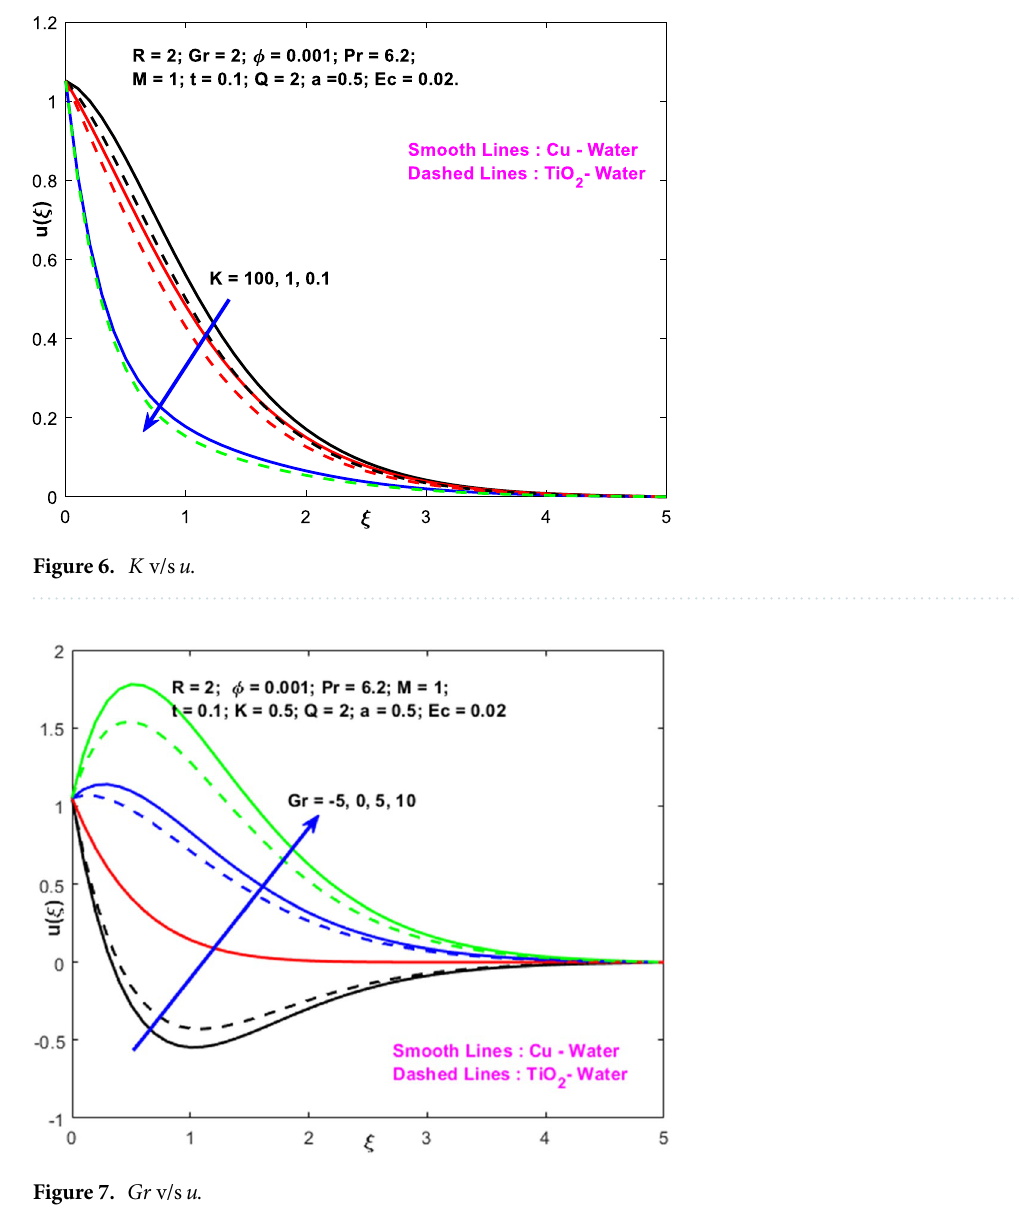
Figure 7. Gr v/s u